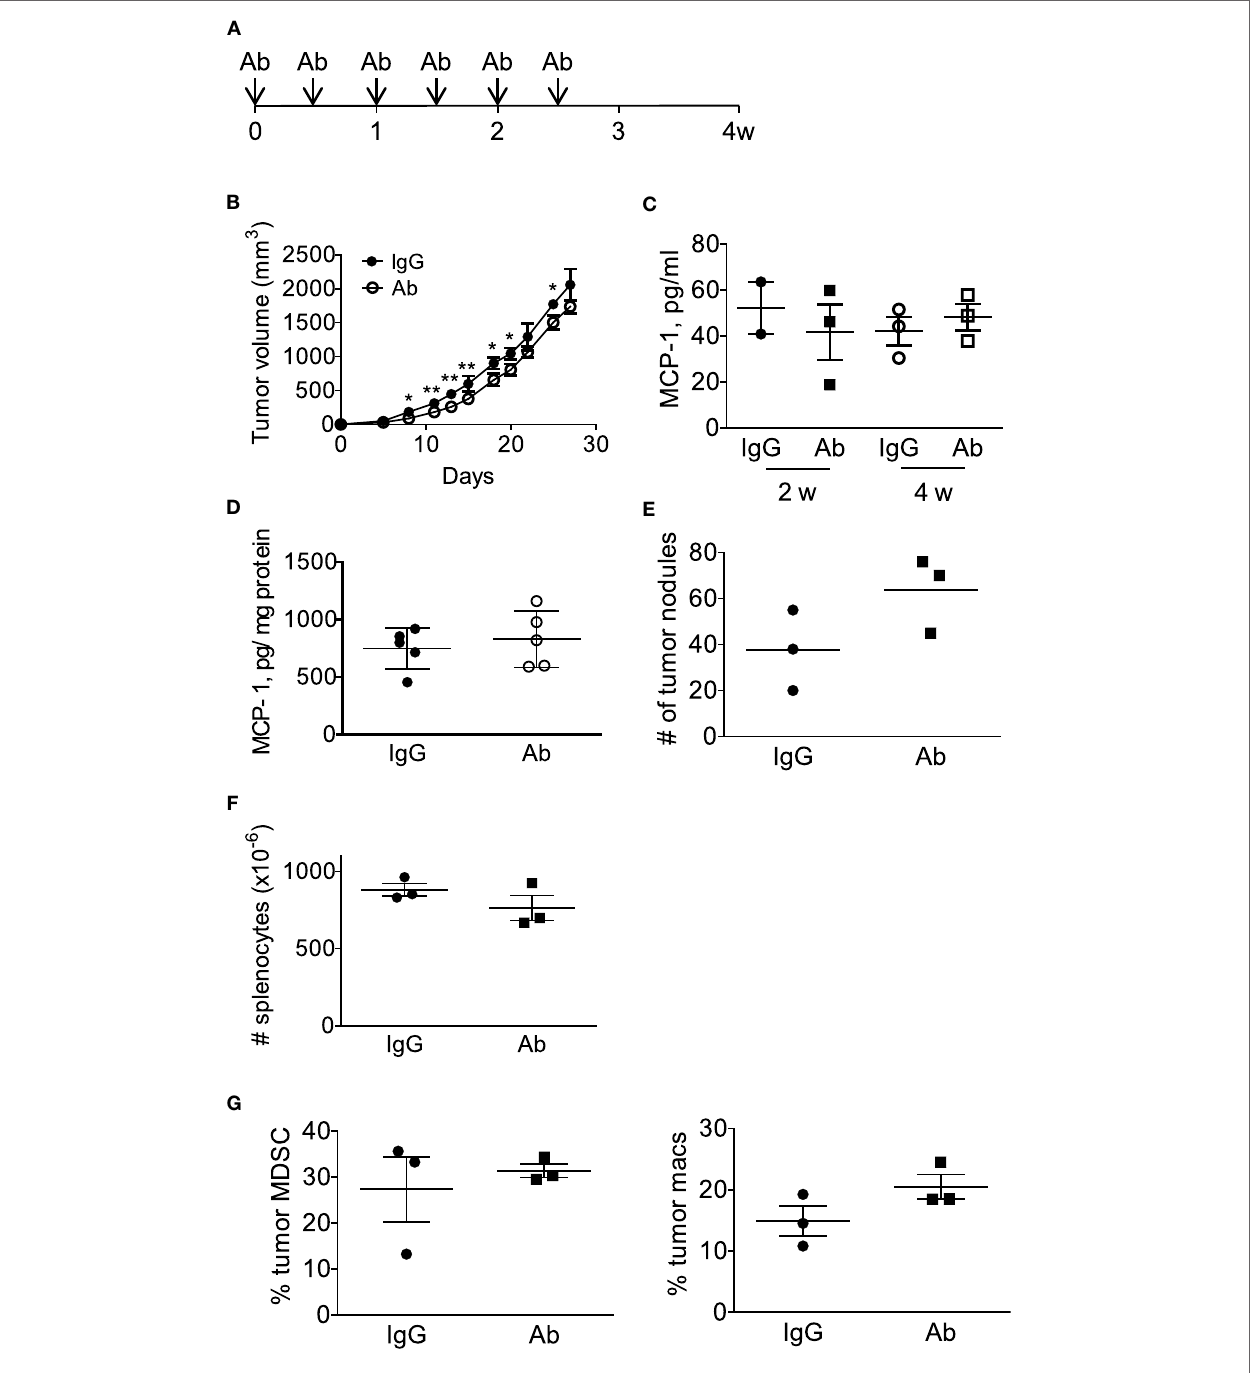
FigUre 6 | anti-gM-csF treatment of 4T1 tumor-bearing mice had a limited effect on tumor progression. (a) The scheme of systemic antibody treatment is shown. One hundred micro gram of either control rat IgG or anti-GM-CSF Ab was intraperitoneally injected on day 0, 3, 7, 10, 14, 18. Mice were euthanized on day 28. (B) The size of tumor in each mouse was measured, and the volume was calculated. The results are shown as the mean ± SD, n = 3, * p < 0.05 , ** p < 0.01 . (c) Serum samples were collected on day 14 and day 28, and the MCP-1 concentration was measured by ELISA. The results are shown as the mean ± SD, n = 3. (D) Tumors were homogenized in RIPA lysis buffer-containing protease inhibitors and the homogenates were spun and the supernatants were frozen at − 20°C until use. The concentration of MCP-1 was analyzed by ELISA, and the concentration of total protein in the tumor lysates was determined by BCA protein assay kit. The results are shown as the mean ± SD, n = 5. (e) The number of tumor nodules on the lung of each mouse was counted on day 28. The results are shown as the mean ± SD, n = 3. (F) The number of splenocytes of each mouse was counted on day 28. The results are shown as the mean ± SD, n = 3. (g) The percentage of tumor-infiltrating CD11b + Gr1 low F4/80 − MDSC or F4/80 + macrophages in CD45 + cells was analyzed by flow cytometry. The number of tumor nodules on the lung of each mouse was counted on day 28. The results are shown as the mean ± SD, n =